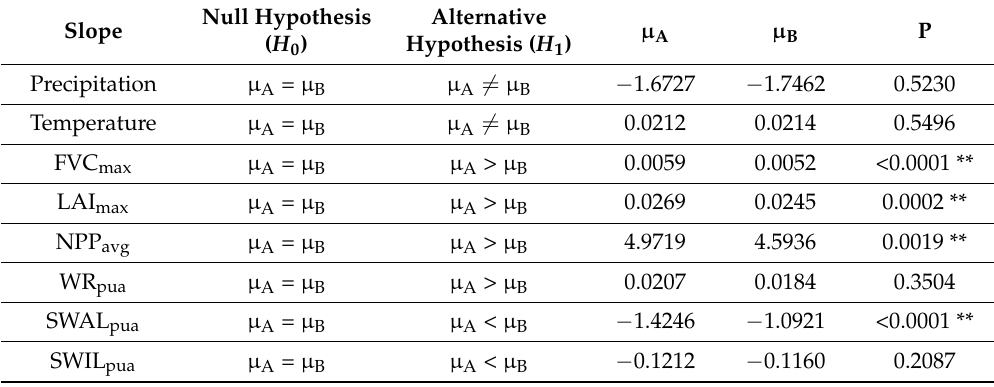
Table 7. Null hypothesis and alternative hypothesis for the slope of changes of climate, ecosystem quality, and ecosystem services indicator values between Sample A and Sample B from 2000 to 2010. µ A and µ B are, respectively, the mean of the slope value of Sample A and Sample B, and the units from top to